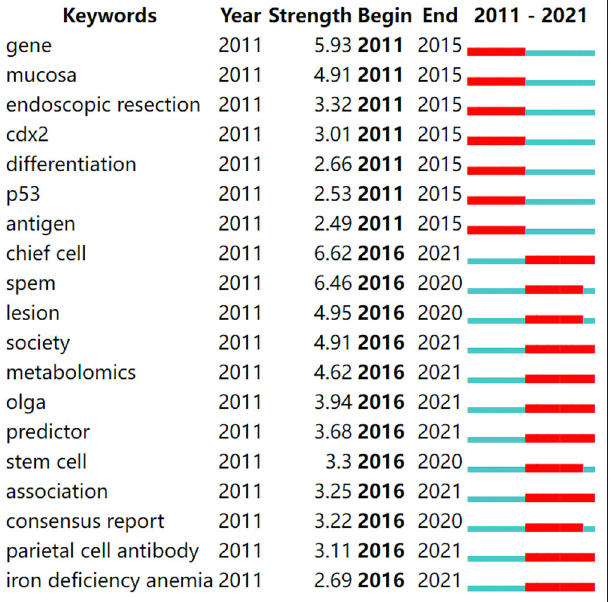
Supplementary Figure 1 | The annual publication numbers of the top three